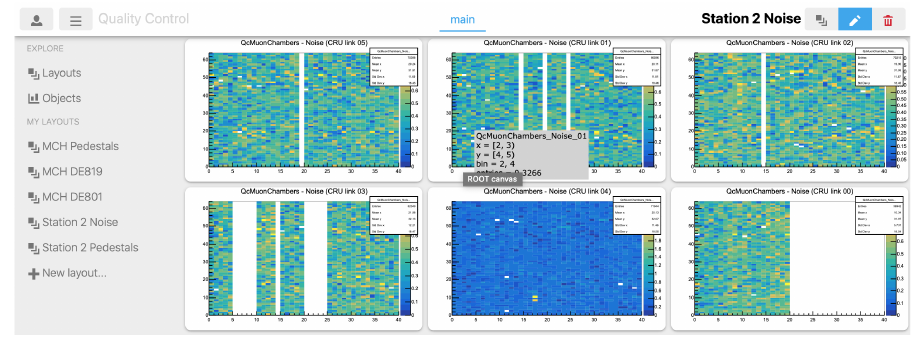
Figure 6. Pads’ noise level of the Muon Chambers detector as shown in the QC GUI.